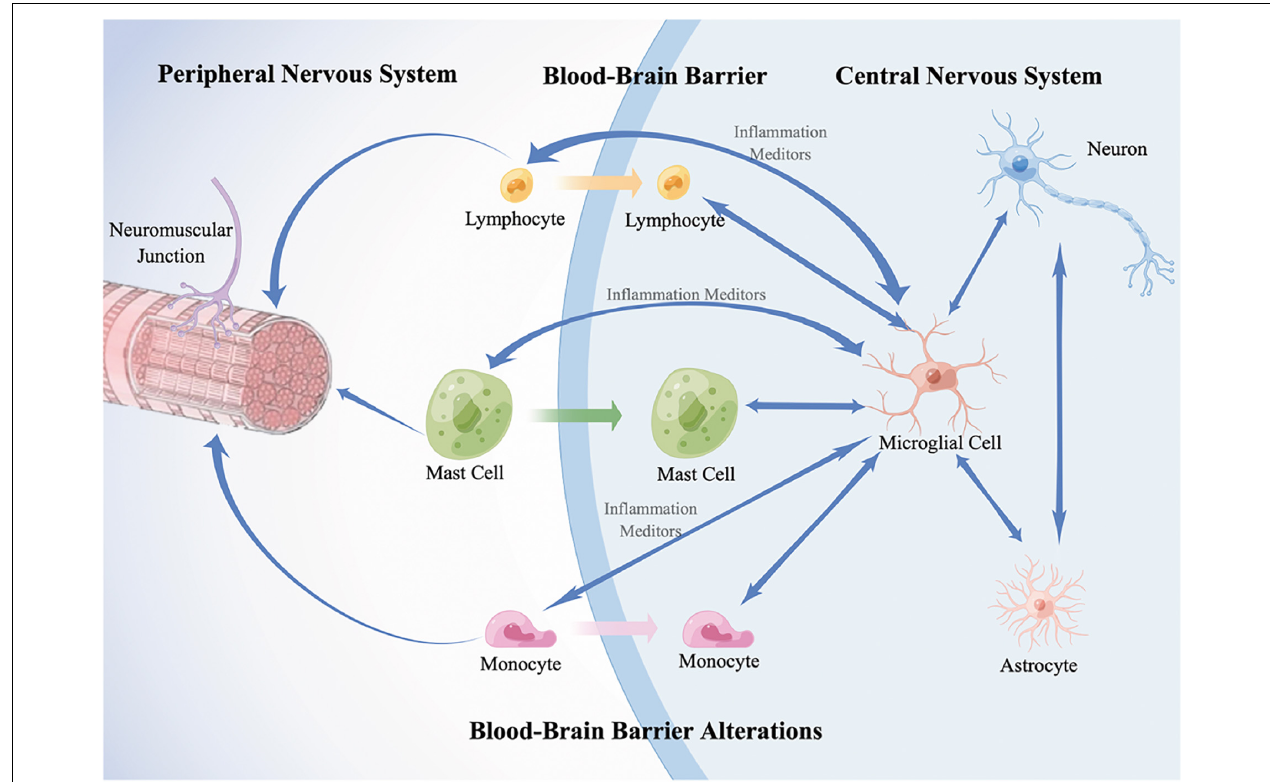
FIGURE 1 | A schematic diagram of immune crosstalk between PNS and CNS. In the CNS, resident immune cells, microglia, are activated and mediate the neuroinflammation by the release of proinflammatory or anti-inflammatory substances such as cytokines and interact with infiltrated peripheral immune cells; astrocytes control the activation, migration, proliferation of microglia. In the PNS, resident immune cells, including T lymphocytes, mast cells, and monocytes are activated and infiltrate along the peripheral motor nerve and neuromuscular junction. Meanwhile, they infiltrate into CNS triggered by microglia-derived inflammation mediators. In addition, dysfunction of CNS barriers, including the blood-brain barrier (BBB) and the blood-spinal cord barrier (BSCB), contribute to the infiltration of peripheral immune cells and accelerate the harmful interaction. As a result, inflammatory responses spread across the two systems contribute to the death of motor neurons (MNs), injuring MN axons, and the dysfunction of neuromuscular junctions. Double-headed arrows represent the communication of two cells. Blue single arrows represent that the cells release inflammatory mediators and influence their targets. Orange, green, and purple arrows represent that the peripheral cells infiltrate into the CNS,